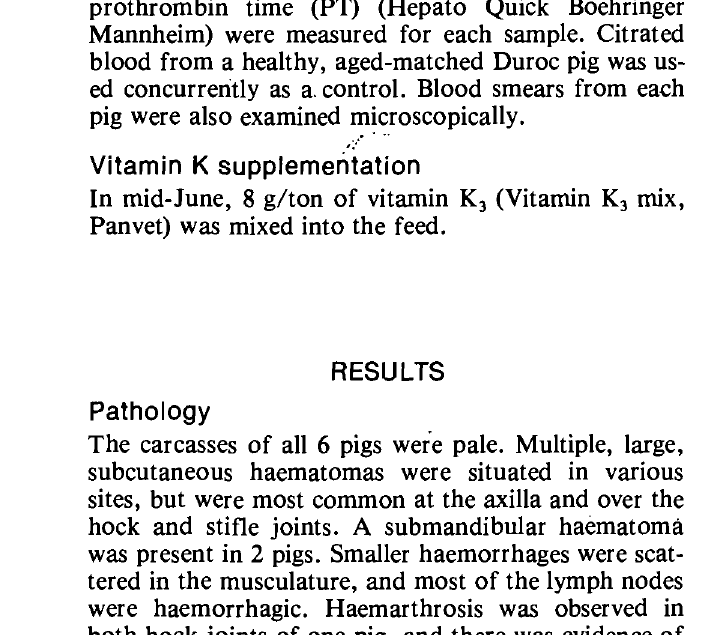
Table 1: ACTIVATED PARTIAL THROMBOPLASTIN TIMES AND PROTHROMBIN TIMES IN AFFECTED PIGS AND